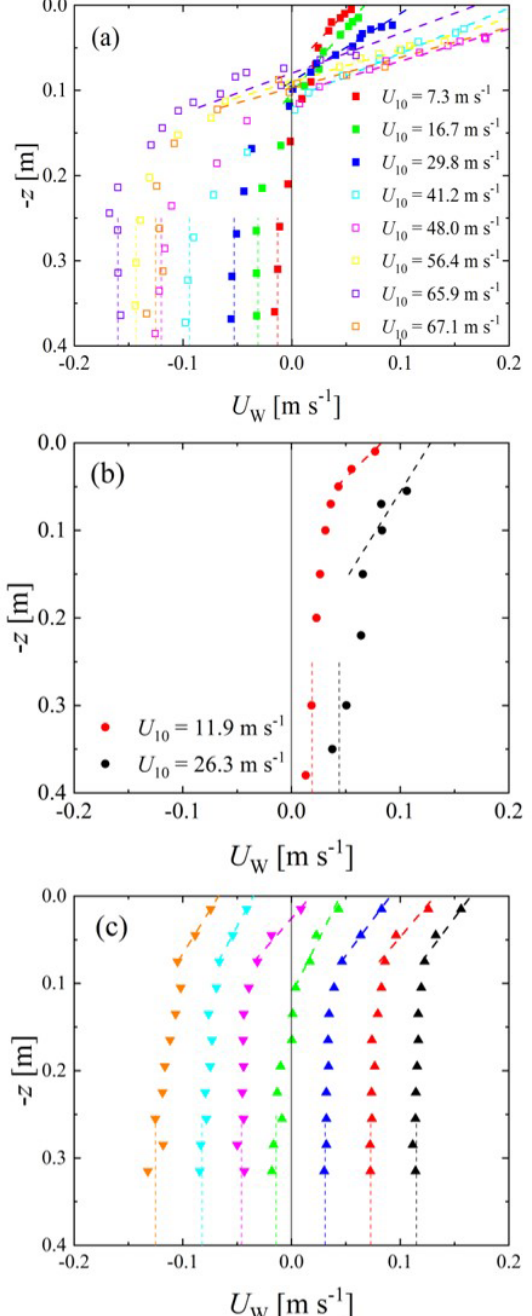
Figure 2. Vertical distributions of water flow velocity; (a) Kyoto University, (b) IAP RAS, and (c) Kindai University. In (c) , plots indicate cases 21–27 starting from the right. Dotted and dashed lines indicate the lines used to estimate U BULK and U SURF , respectively. Open symbols show the high-wind-speed